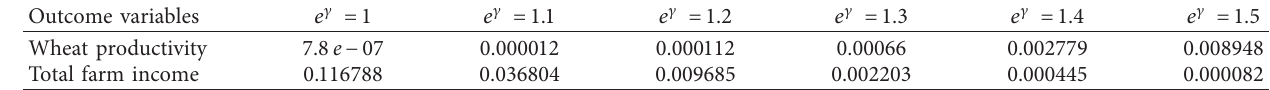
Table 11: Result of sensitivity analysis.